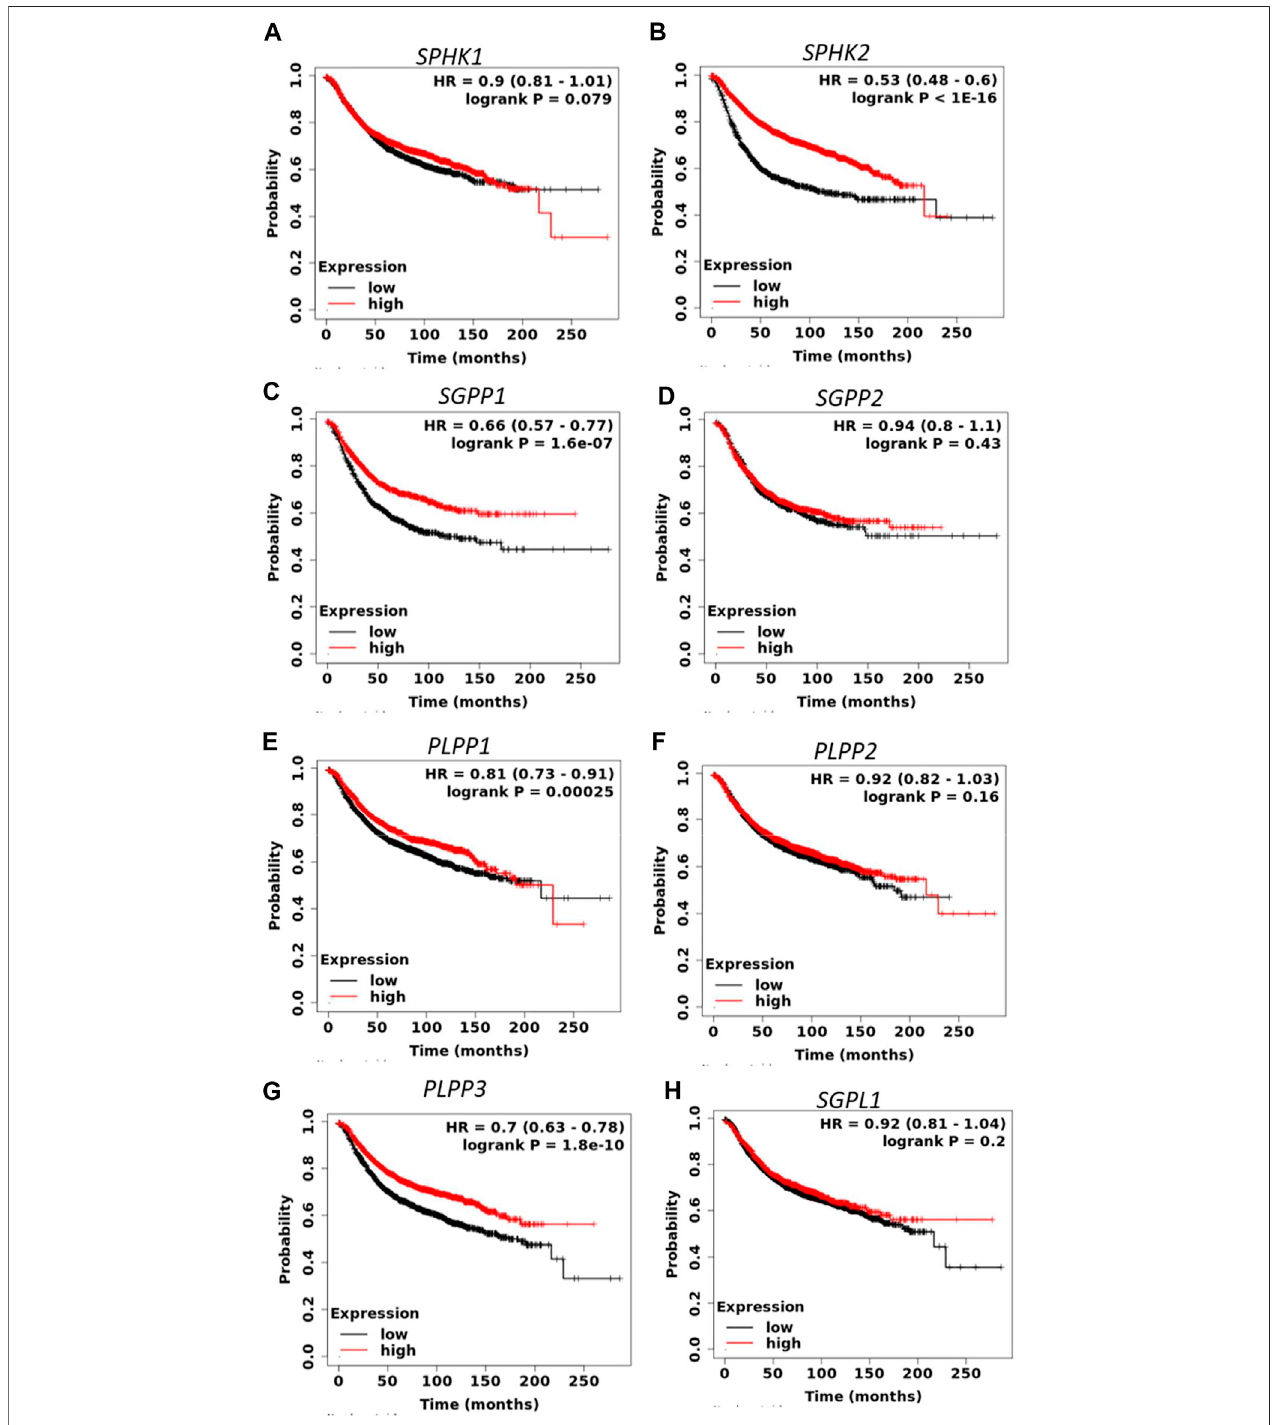
FIGURE 1 | Prognostic role of mRNA expression of S1P-metabolizing enzymes (A – H) in breast cancer patients. Kaplan – Meier survival curves (RFS) were plotted for S1P-metabolizing genes from the publicly available KM plotter database (N (cid:2) 3955 BC).